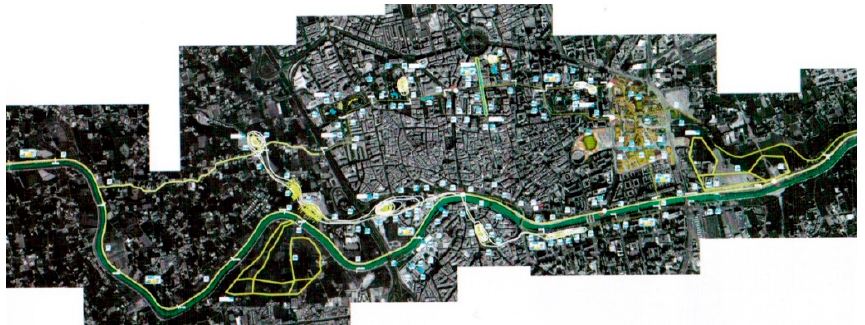
Figure 17. La Ciudad Maclada masterplan, La Paz, Murcia. Mobility strategies: green, bike, and pedestrian lanes connecting the neighborhood to the city. Drawing: Xpiral & Colectivo Baquía.